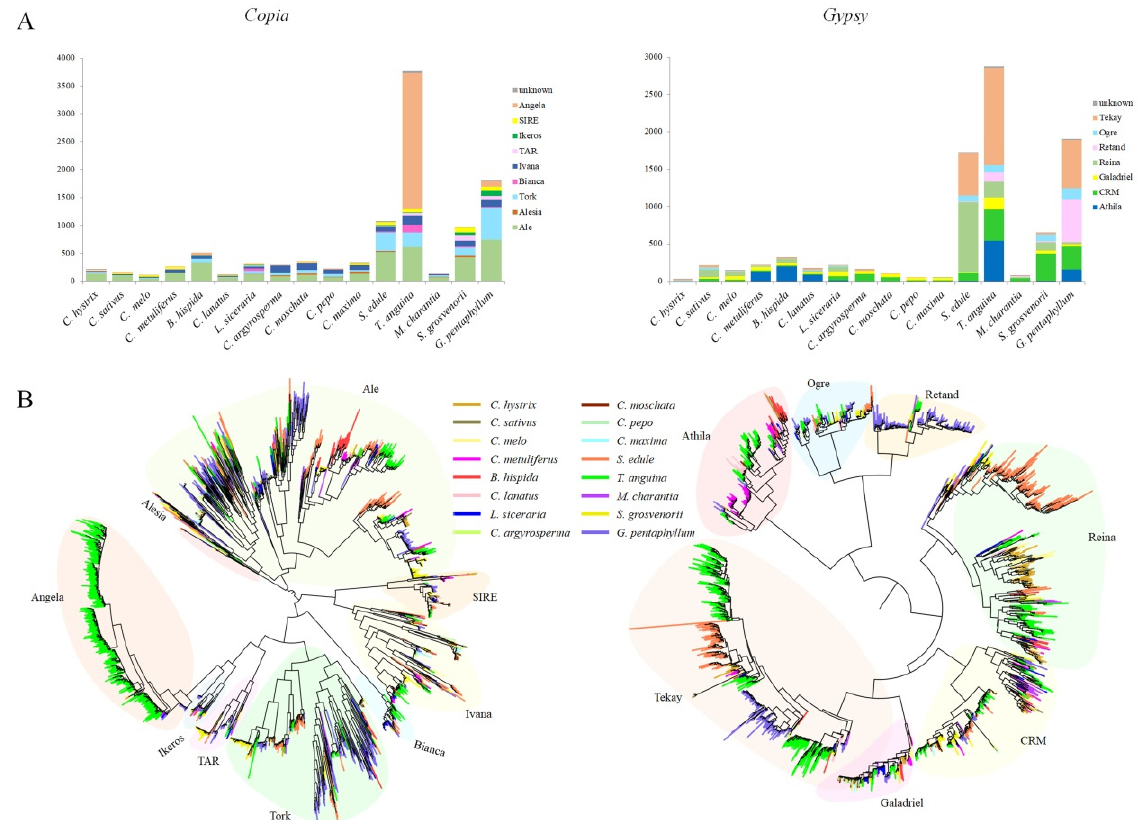
Figure 5. Diversity and evolution of LTR-RT lineages. ( A ) Number of full-length LTR-RTs belonging to different lineages of Copia and Gypsy superfamilies identified in the Cucurbitaceae genomes; ( B ) phylogenetic trees constructed based on reverse transcriptase domain sequences.